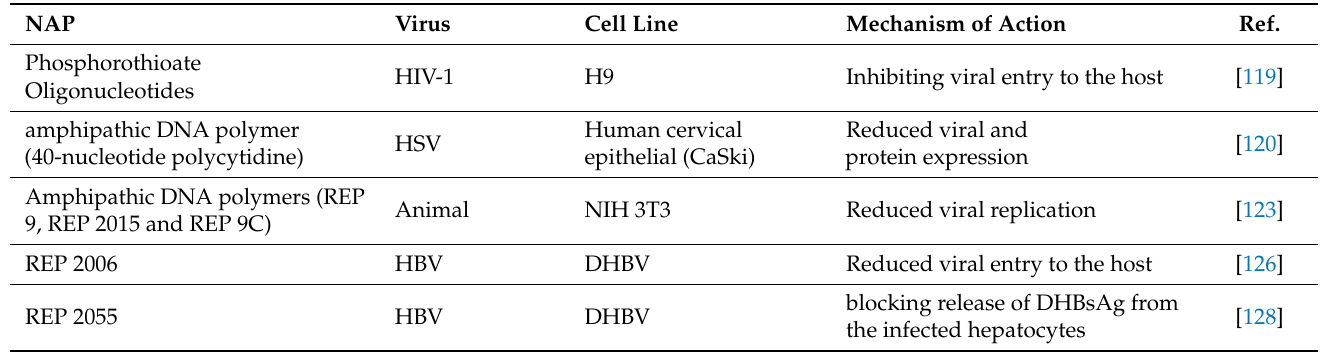
Table 5. Antiviral activity of NAPs against different viruses with their mechanism of